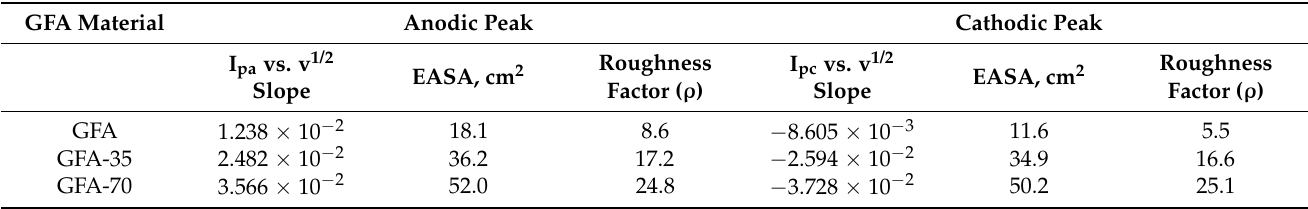
Table 4. Electroactive surface area (EASA) and roughness factor ( ρ ) of the tested GFA materials calculated from the dependence of I pa and I pc vs. v 1/2 determined in K 4 [Fe(CN) 6 ] (5 × 10 − 3 mol L − 1 in 0.1 mol L − 1